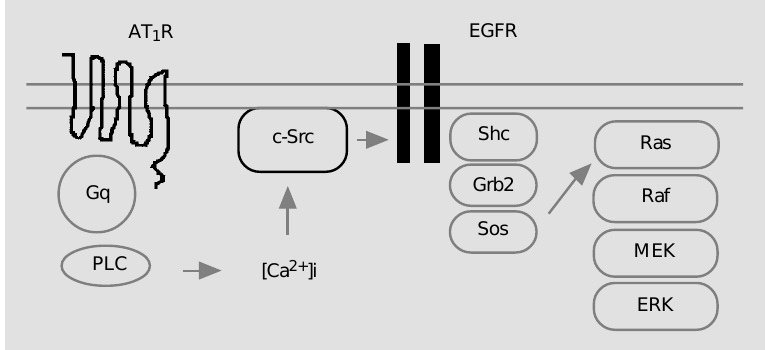
Figure 2 - In VSMC, Ca 2+ -dependent transactivation of epidermal growth factor receptor (EGFR) mediates Ang II-induced Ras/ERK MAPK activation. AT 1 R, Type 1 angiotensin II receptor; PLC, phospholipase C; ERK, extracellular signal-regulated kinase; MEK, MAPK